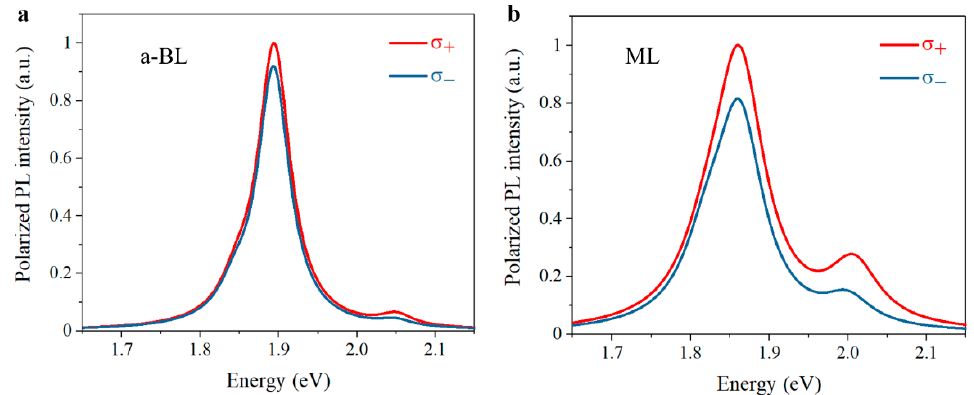
Figure 15. Normalized polarization-resolved PL spectra. ( a ) a-BL, anomalous bilayer. ( b ) ML, monolayer. The 2.2 eV excitation laser is left-circularly ( σ + ) polarized. Co-polarized and cross- polarized PL components are marked in red and blue, respectively.